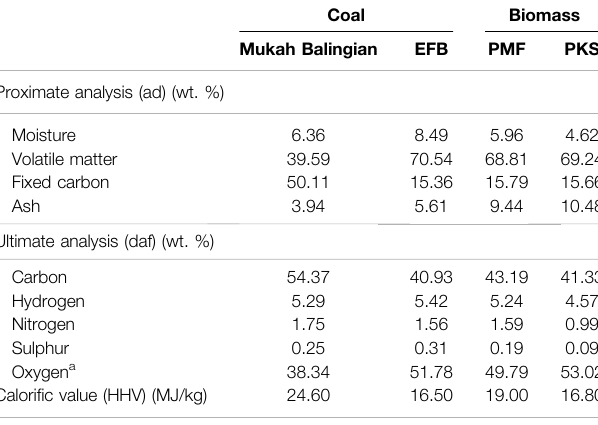
TABLE 1 | Characterisation of Coal Mukah Balingian, empty fruit bunch (EFB), TABLE 2 | Factor and level used for design of experiment palm mesocarp fi bre (PMF), and palm kernel shell (PKS). Coal Biomass